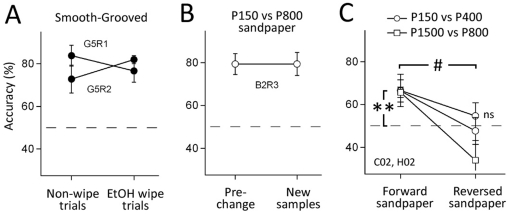
Olfactory cues do not mediate texture discrimination.
A, Cleaning smooth-grooved surfaces with ethanol between trials (“EtOH wipe trials”) did not reduce discrimination performance relative to interleaved “non-wipe” trials. B, Exchanging P150 and P800 sandpaper samples that were used daily with new samples of each sandpaper did not alter discrimination accuracy. C, Reversing the sandpapers so that the paper backing, rather than the grit surface, faced the rat abolished discrimination. **, discrimination significantly greater than chance (p<0.0003). #, significantly less than the forward condition (p<0.04).